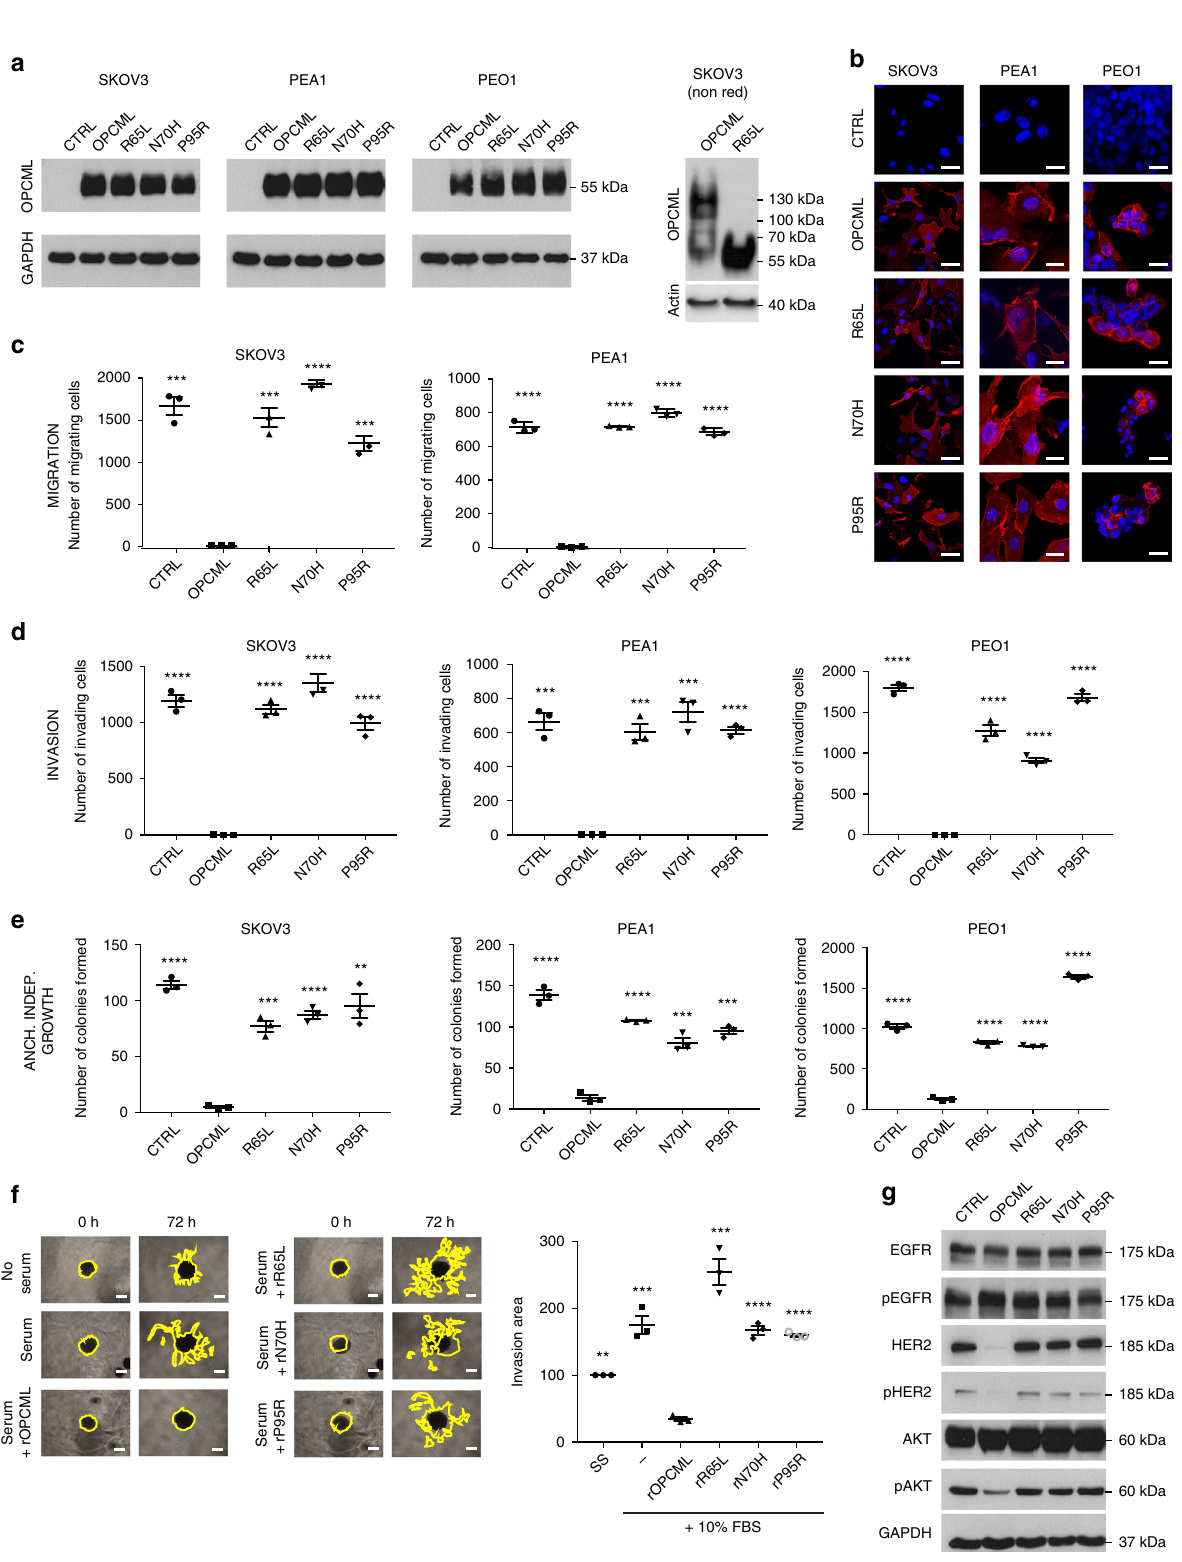
investigated the effect of adding mutant recombinant OPCML proteins in a 3D invasion model. Whereas pre-treatment with WT OPCML protein completely blocked the serum-stimulated invasion of cancer cells into the matrix, the cells pre-treated with mutant protein were unable to impair invasion, corroborating our fi ndings in transduced cells (Fig. 3f).